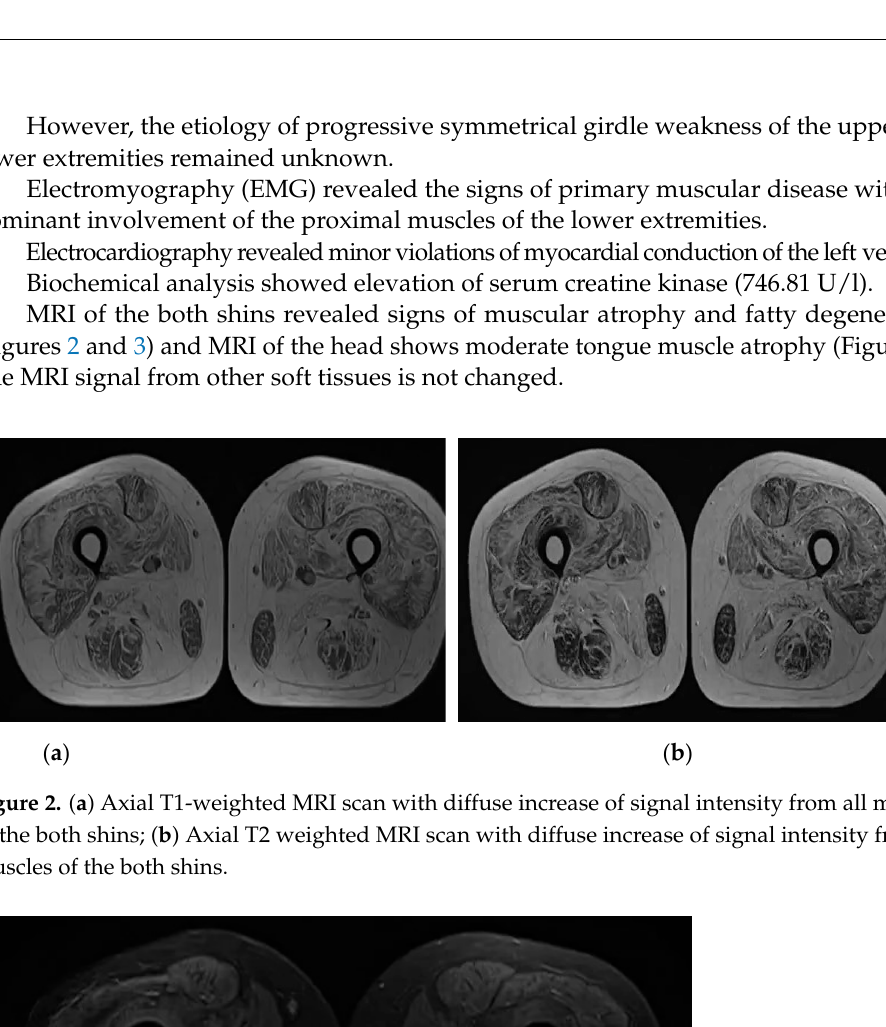
Table 1. Identified variants of uncertain significance.